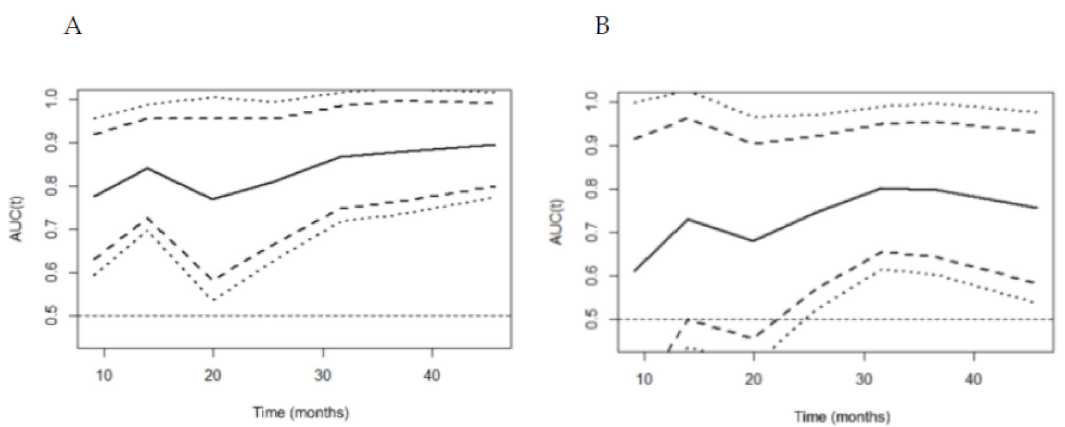
Figure 4. The curve of time-pendent area under the curve (AUC) for predicting the overall survival of the H6C score ( A ) and the model for end-stage liver disease (MELD) ( B ) in patients with viral etiology. The continuous line represents time-dependent AUC, and the dashed line and dotted line show 95% and 99% confidence internal, respectively. The AUCs of the H6C score were consistently higher than those of the MELD over